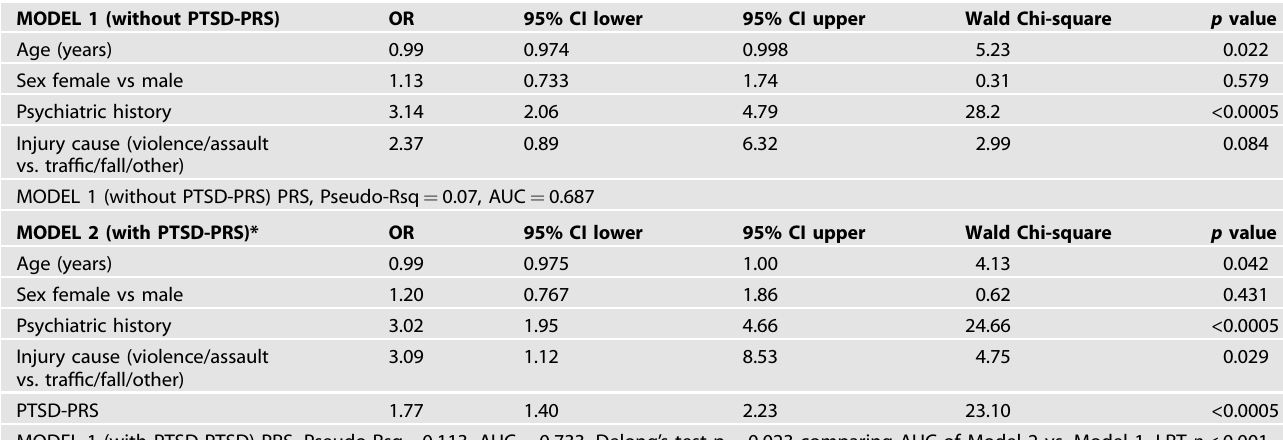
Table 2. Multivariable logistic regression models assessing the association between various risk factors and probable PTSD at 6 months post-injury. a Multivariable logistic regression model assessing the association between PTSD polygenic risk score (PTSD-PRS) and odds of probable PTSD at 6 months post-injury.